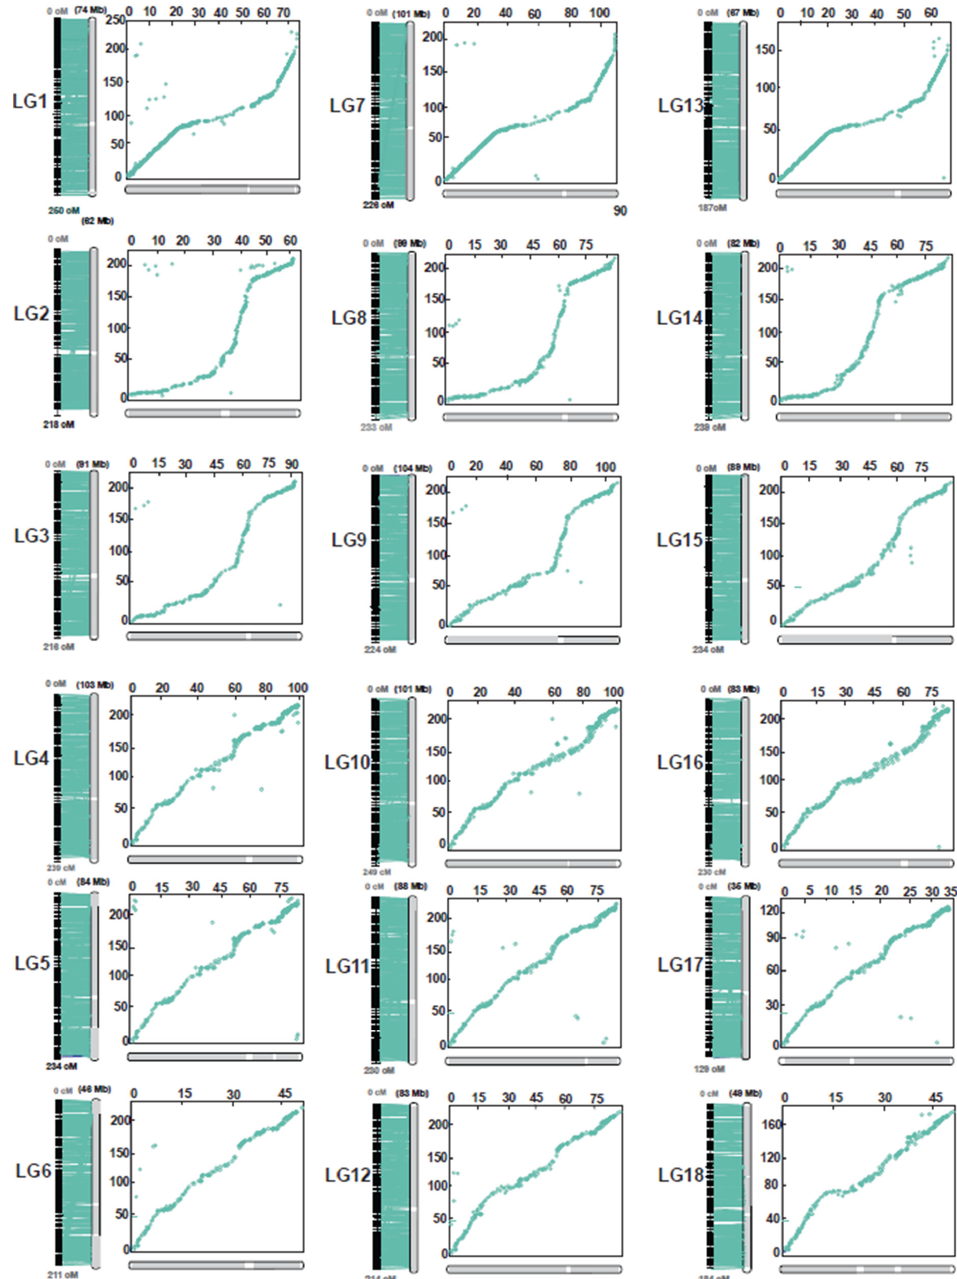
Figure 4. Relationship between the linkage map and the reference genome of Hevea brasiliensis . Each panel shows the genetic positions of markers on the linkage map (vertical axis, in cM) plotted against the physical positions of the same markers on the corresponding pseudomolecule of the reference genome (horizontal axis, in Mb). The right part represents the genetic and physical locations of the